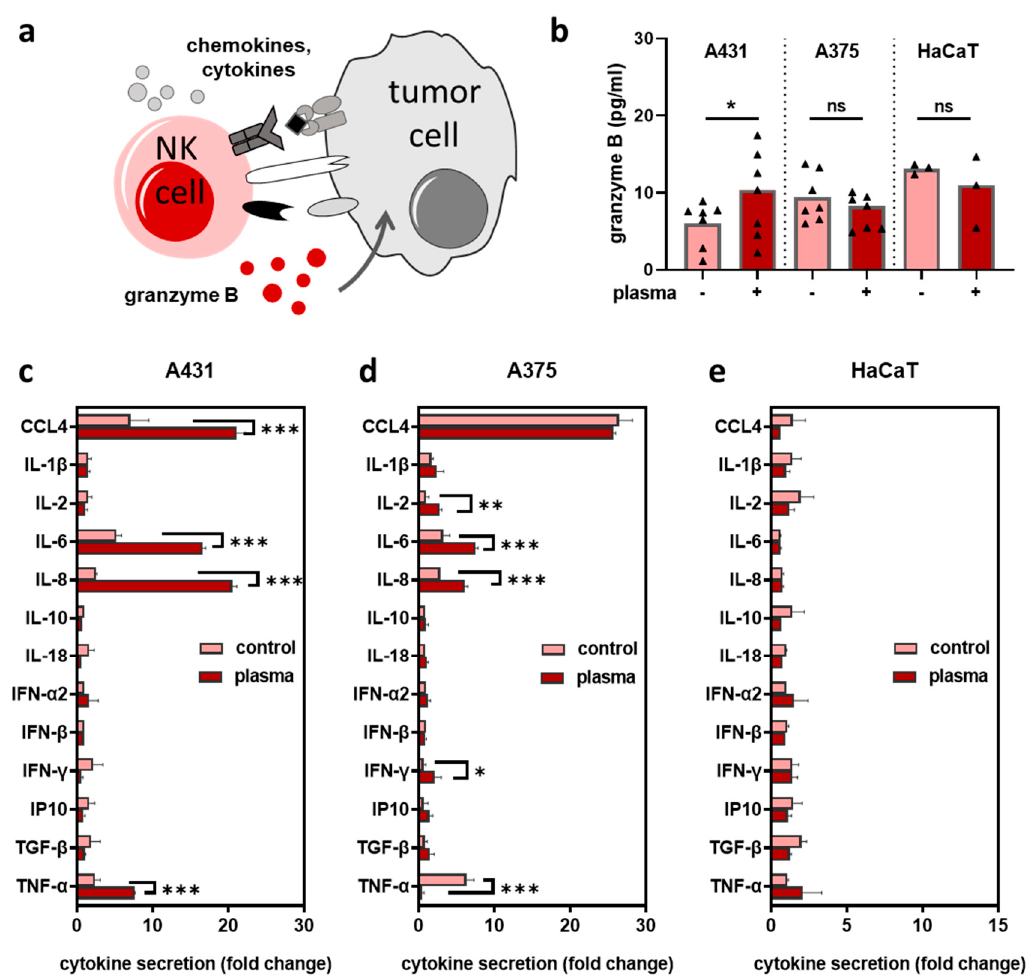
Figure 4. Plasma-treated skin tumor cells stimulated the secretion of inflammatory mediators upon co-culture with NK-cells. ( a ) simplified scheme and consequences of NK-cell-tumor cell interaction; ( b ) granzyme B quantification in supernatants of co-cultures (±plasma treatment) at 4 h, 6 h, and 24 h (A431 and A375) and 24 h (HaCaT); ( c – e ) quantification of cytokines in co-cultures in supernatants of untreated (vehicle) and plasma-treated A431 (c ), A375 ( d ), and HaCaT ( e ) cells at 24 h as a ratio to the respective single tumor cell or HaCaT keratinocyte culture. Data are the mean of three independent experiments. Statistical analysis was performed using t-test or two-way ANOVA (* = p < 0.01, ** = p < 0.01, *** = p < 0.001, ns = not significant).